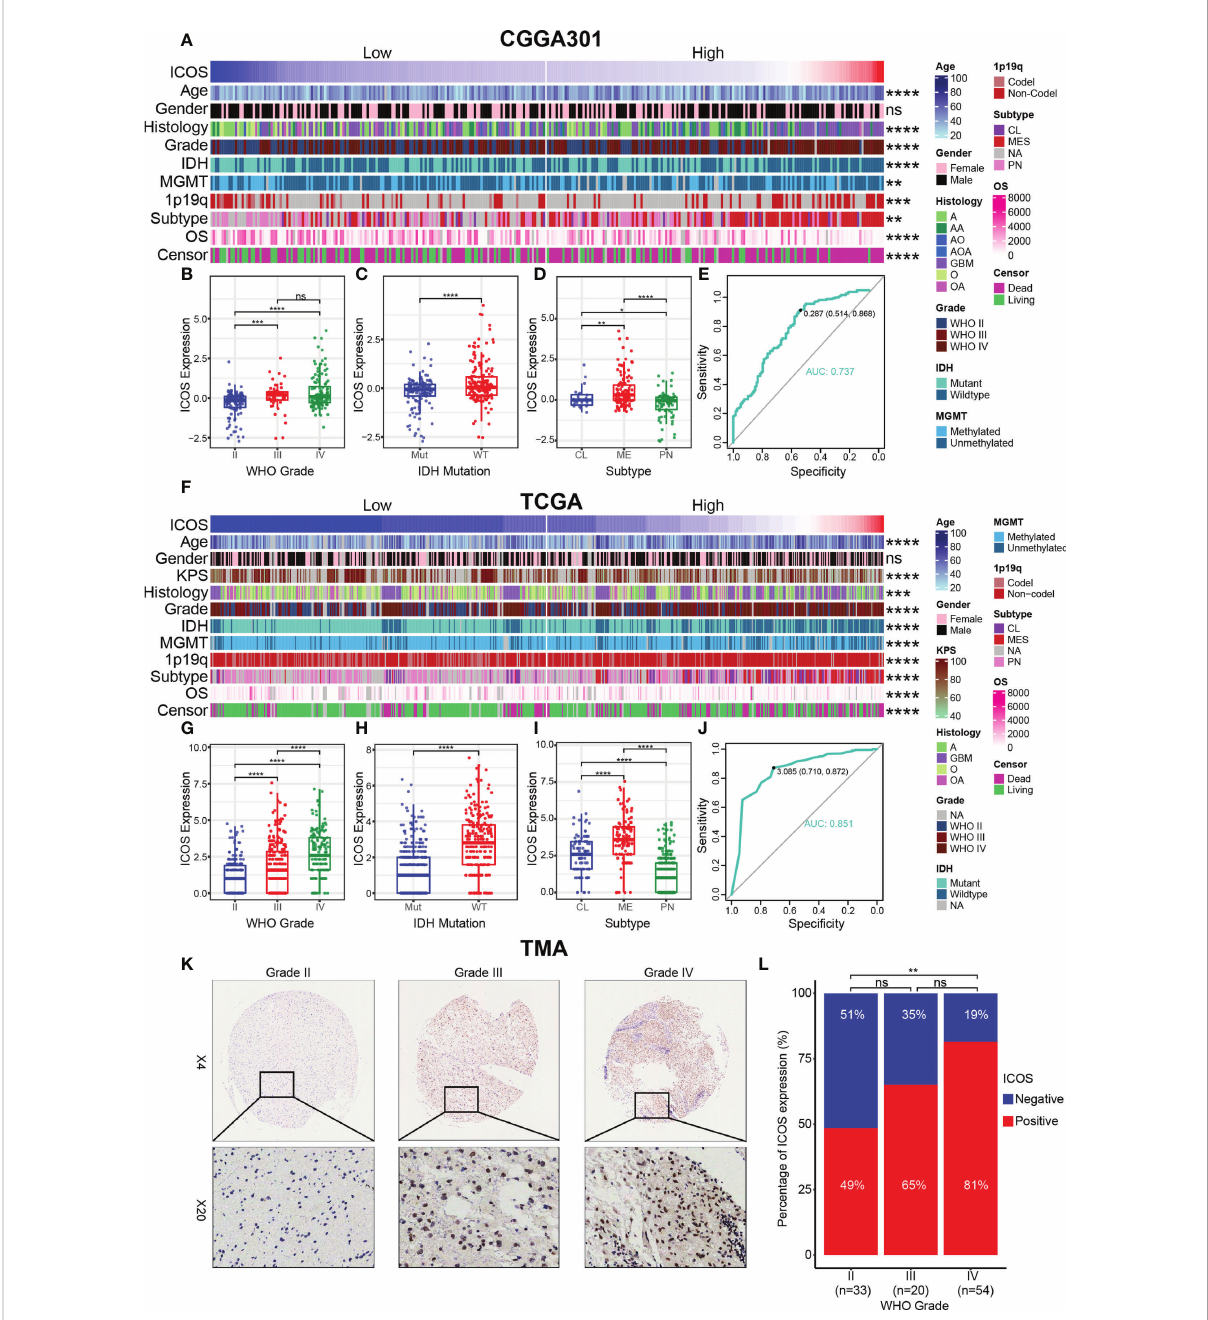
FIGURE 1 Relationship between ICOS expression and pathological characteristics. (A) The distribution of clinical and pathological characteristics arranged by the increasing ICOS expression in the CGGA301 dataset. (B – D) Distribution of ICOS expression in patients strati fi ed by WHO grade, IDH mutation status, and TCGA molecular subtype in the CGGA301 dataset. (E) ROC curve to evaluate the sensitivity and speci fi city of ICOS expression to predict the mesenchymal subtype glioma in the CGGA301 dataset. (F) The distribution of clinical and pathological characteristics arranged by the increasing ICOS expression in the TCGA dataset. (G – I) Distribution of ICOS expression in patients strati fi ed by WHO grade, IDH mutation status, and TCGA molecular subtype in the TCGA dataset. (J) ROC curve to evaluate the sensitivity and speci fi city of ICOS expression to predict the mesenchymal subtype glioma in the TCGA dataset. (K) Representative images of IHC staining for ICOS across different WHO grades of gliomas. (L) Comparison of IHC staining distribution (ICOS-negative or ICOS-positive) in different WHO grades of gliomas. * indicates p value < 0.05, ** indicates p value < 0.01, *** indicates p value < 0.001, **** indicates p value < 0.0001. ns, not signi fi